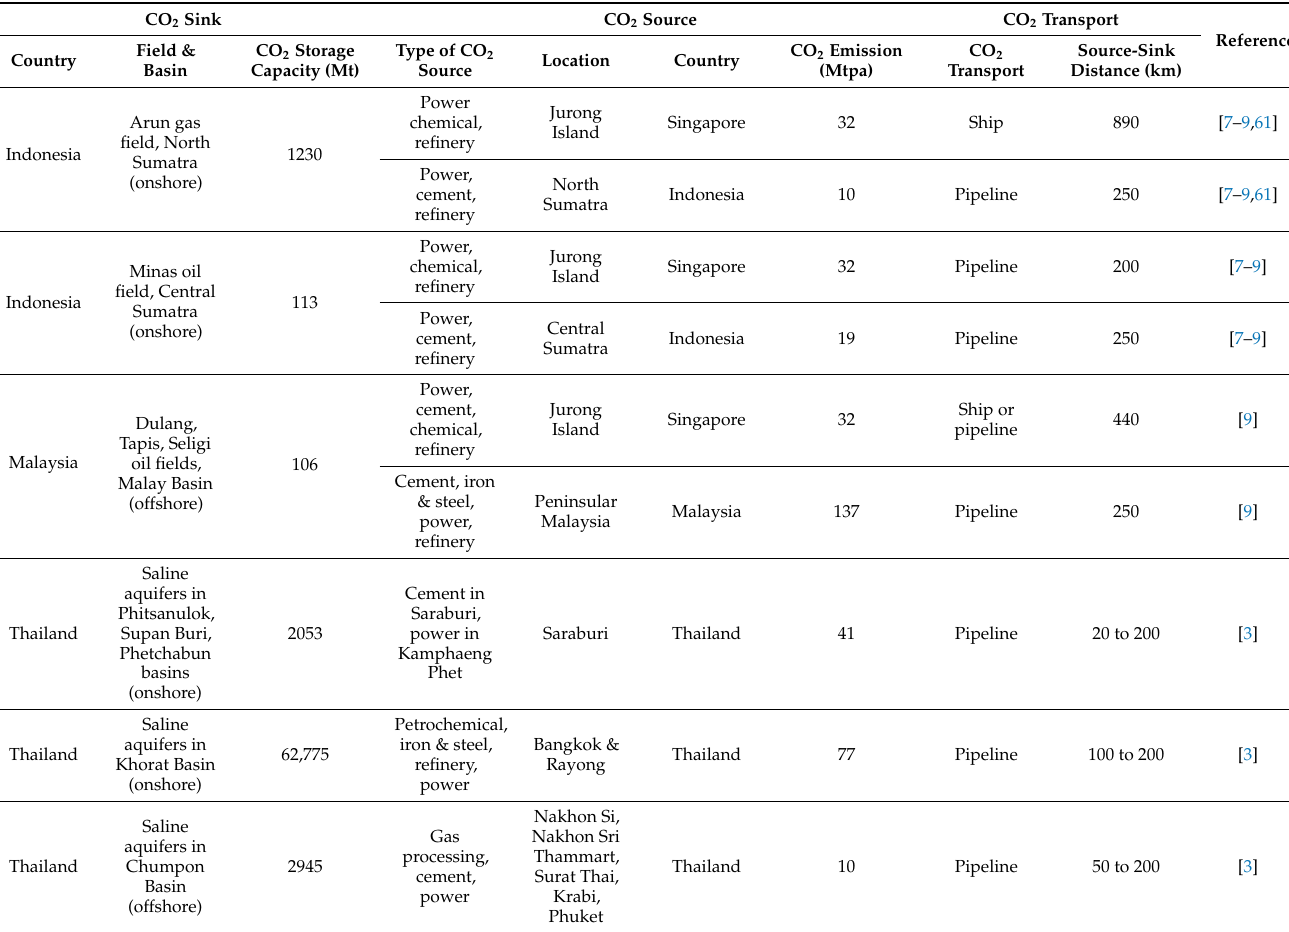
Table 5. Proposed first-mover CCS projects in